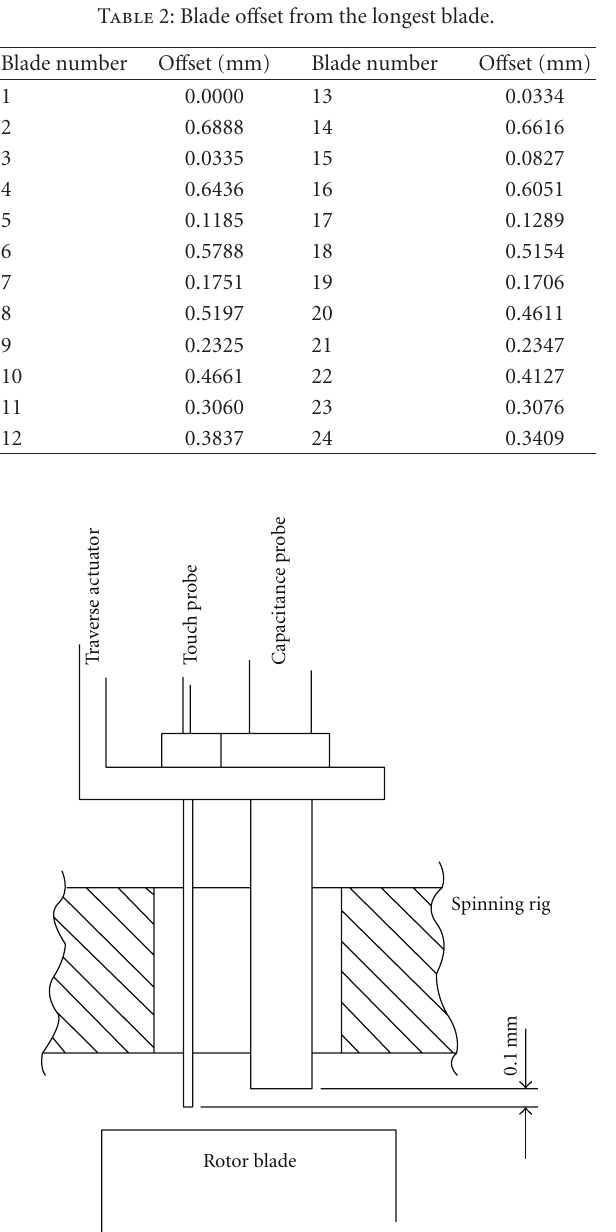
Figure 6: FM capacitance probe and touch wire mounting arrangement on the traverse actuator carrier.